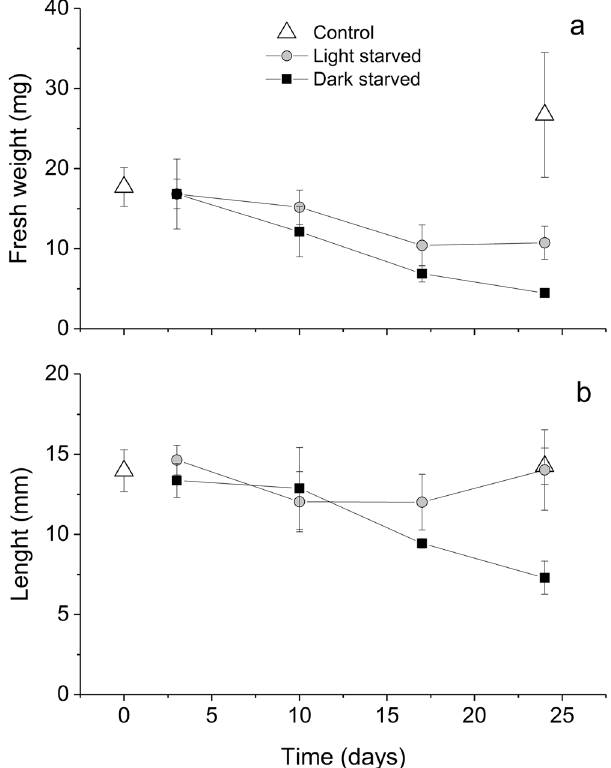
Figure 1. Changes in growth parameters of Elysia viridis with light and starvation. Fresh weight ( a ) and length ( b ) (mean ± standard deviation, n = 3) of animals feeding on Codium tomentosum (control) and starved under 14:10 h light:dark cycle (light-starved) and continuous darkness